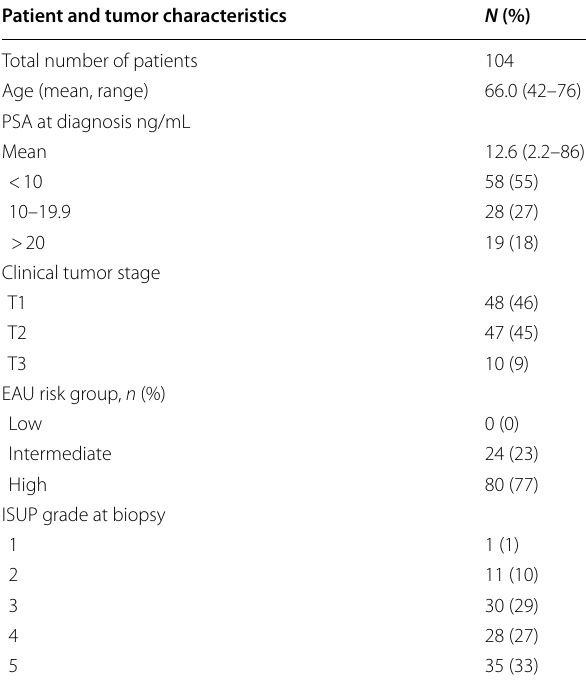
Table 1 Characteristics of patients in final analyses Patient and tumor